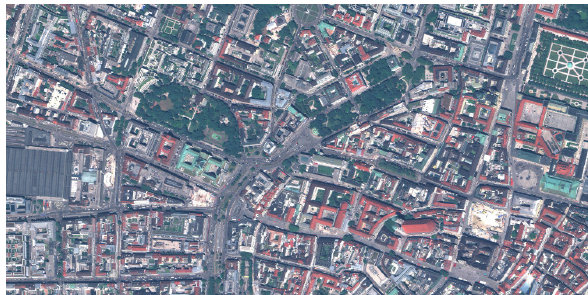
Figure 15. Section 1800 × 900 m 2 of WorldView-3 image, Munich, acquired 2019-07-04, 10:21:26 UTC, ( c (cid:13) European Space Imaging, 2019), left edge: Hauptbahnhof, right edge: Residenz